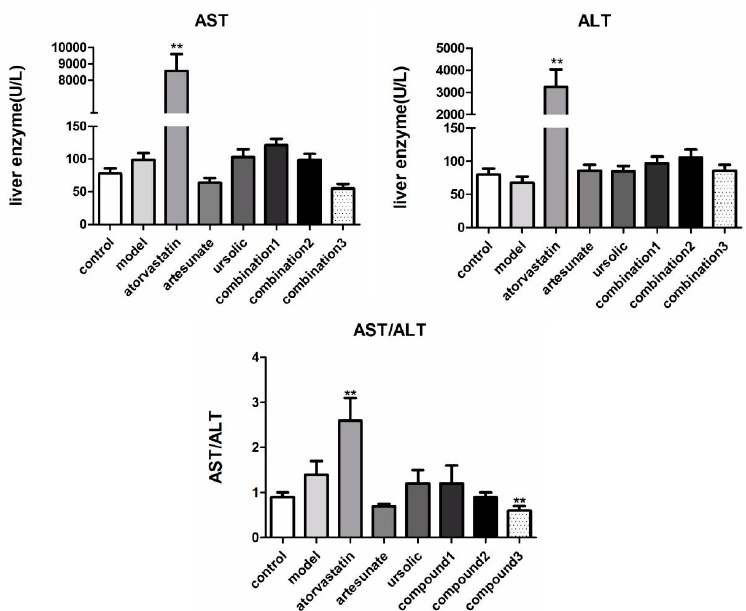
Figure 2. The effect of each administration group on alanine aminotransferase (ALT) and aspartate aminotransferase (AST) in high-fat rats. The groups were divided as eight groups: control group; model group; positive control (atorvastatin group, 10 mg/kg); artesunate group (20 mg/kg); ursolic acid group (20 mg/kg); combination group 1 (artesunate 10 mg/kg + ursolic acid 10 mg/kg); combination group 2 (artesunate 20 mg/kg + ursolic acid 20 mg/kg); combination group 3 (artesunate 40 mg/kg + ursolic acid 40 mg/kg). Values are represented as mean ± SD. Significant difference vs. the model group (** p < 0.01).